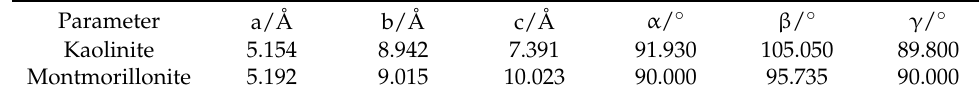
Table 1. Lattice parameters of the unit cell of clay minerals.